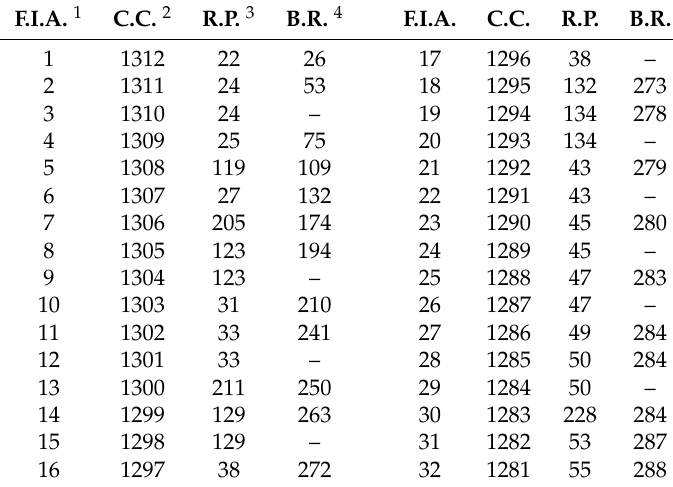
Table 5. Results obtained from the attack on Trivium